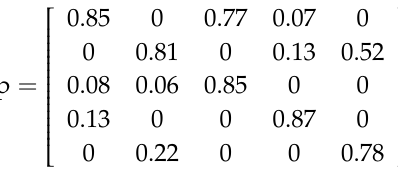
Table 6. The white noise test results of water consumption data difference at monitoring point 2. Stat 5% 316.44 8.62e-71